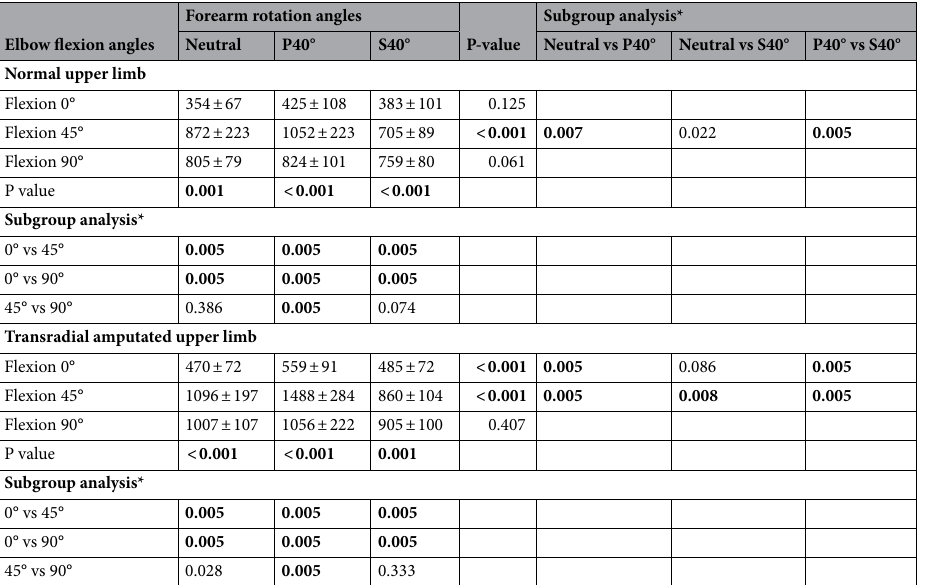
Table 3. Mean pressure of the radiocapitellar joint at various degrees of elbow flexion and forearm rotation angles in normal and transradial amputated upper limbs. P40°, 40° pronation; S40°, 40° supination. Boldface indicates significance. Values are presented as mean ± SD (kPa). *The significance level was corrected from 0.05 to 0.017 (5%/3) by Bonferroni’s